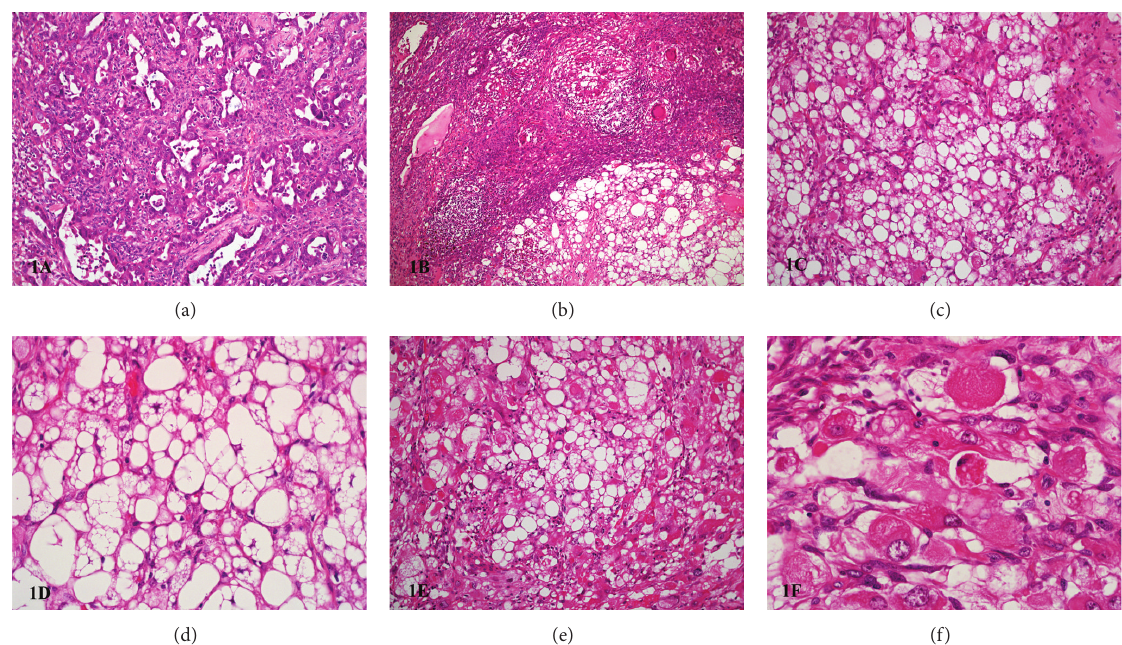
Figure 1: (a) Histologically, there was almost complete effacement of the ovary by a malignant neoplasm with two components. The smaller component, shown here, is composed of trabeculae of markedly atypical epithelial cells, consistent with high grade serous adenocarcinoma. (b) Poorly differentiated carcinoma is seen to abut the predominant sarcomatous component, much of which is composed of sheets of pleomorphic multivacuolated cells. ((c)-(d)) There are extensive sheets of large polygonal cells containing abundant multivacuolated cytoplasm with small hyperchromatic nuclei with prominent nuclear indentations, morphologically suggestive of pleomorphic lipoblasts. (e) Admixed in areas with the vacuolated cells are moderately and markedly pleomorphic ovoid, spindle, and polygonal cells with atypical hyperchromatic nuclei and moderate to abundant amounts of eosinophilic cytoplasm. This appears to represent a transition zone, between more typical rhabdomyoblasts showing cytodifferentiation and the unusual multivacuolated pleomorphic lipoblast-like rhabdomyoblasts. (f) At high power, cytoplasmic cross striations are seen focally within the intermediate